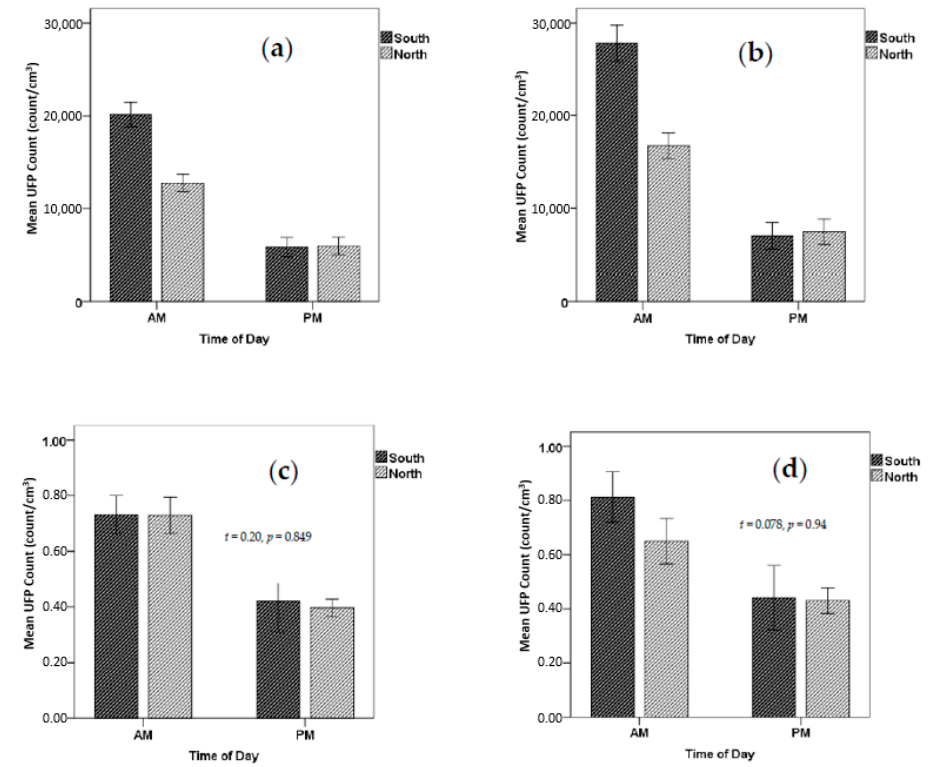
Figure 4. Mean concentrations for each time of day and route ( a ) When travelling the complete route: UFP, ( b ) For the main arterial road segment only: UFP, ( c ) When travelling the complete route CO, ( d ) For the main arterial road segment only: CO (error bars are one standard error of the mean (SEM)).